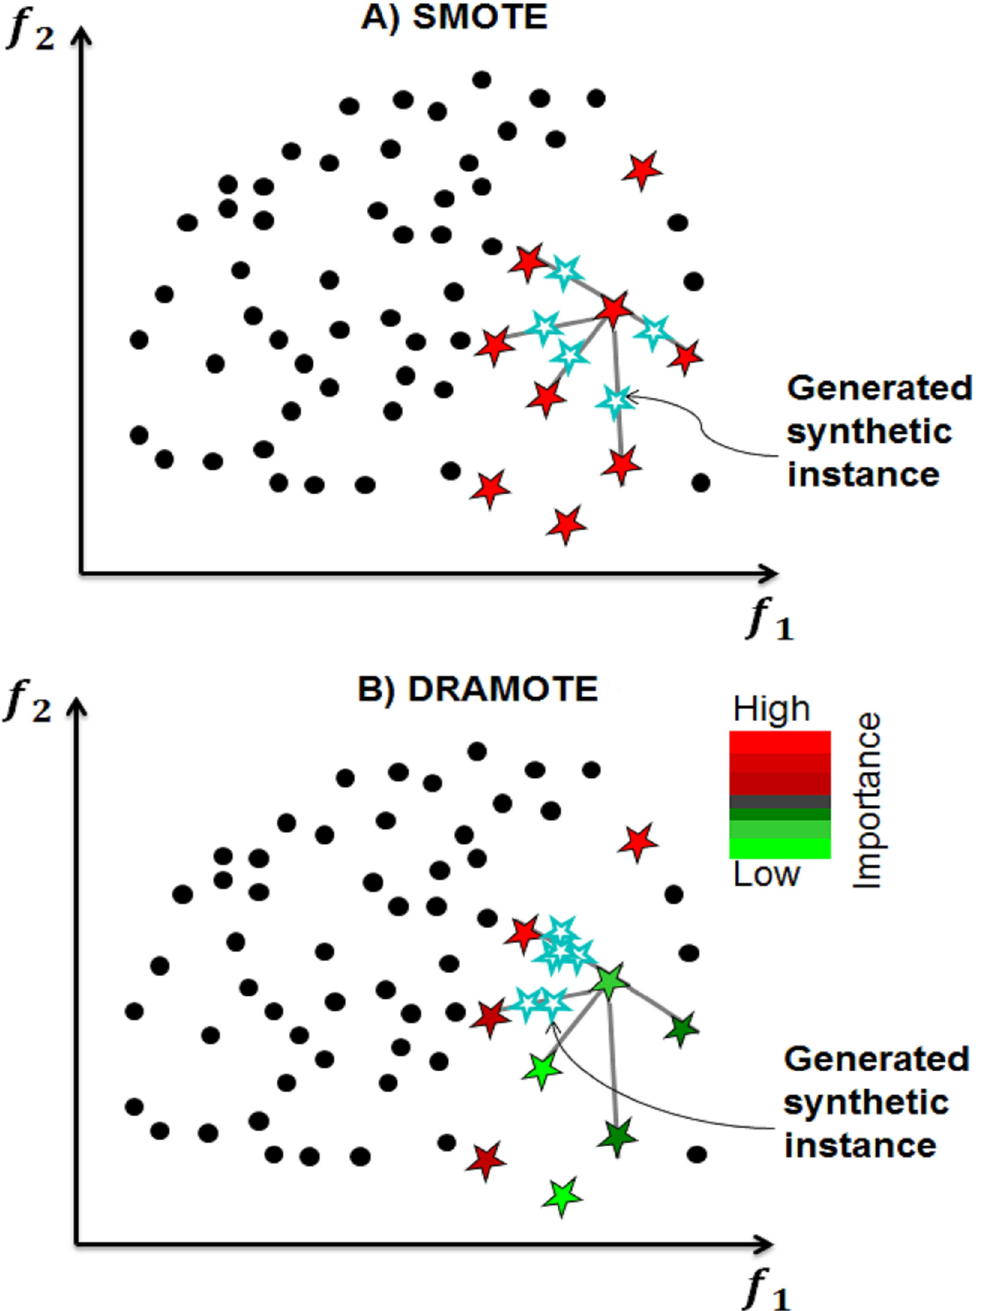
Fig 1. Illustration of generating synthetic instances. A) SMOTE generates the light blue samples by interpolation between a randomly chosen minority sample and k-nearest neighbors. B) DRAMOTE generates the light blue samples by choosing a minority sample based on its importance (i.e. contribution to precision) and the direction towards a safe region. A minority sample (red colored) that is very close to the majority negatives circles will be probably misclassified as a negative one and hence, it should get more support compared to the green colored minority samples. Once a minority sample is chosen, another point needs to be chosen for interpolation. The direction of interpolation can be controlled by choosing a nearest neighbor which is not overlapping with the negative class. This, in turn, helps in providing support for the red colored point while not harming the classifier performance in its surrounding